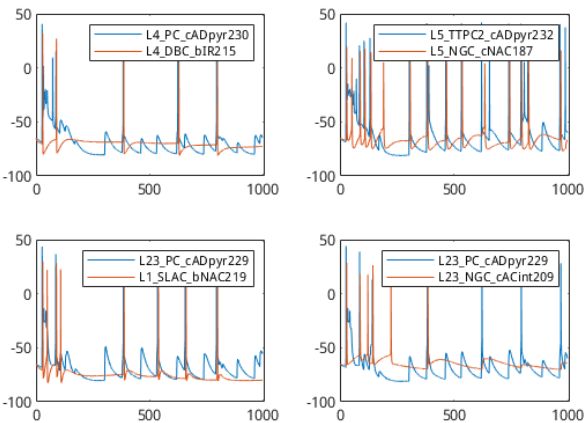
Figure 4. Comparison of 2 − cell network outputs. Head-cell in black, tail-cell in orange. Cell-types shown in each subplot’s